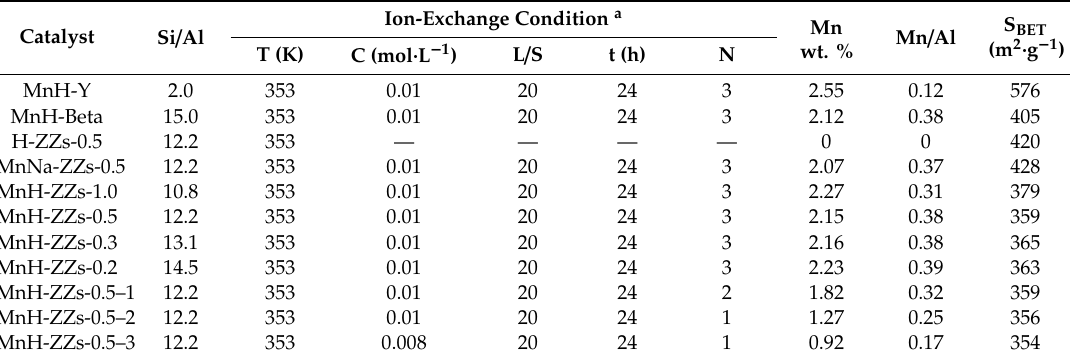
Table 1. Preparation catalyst and the selected physical